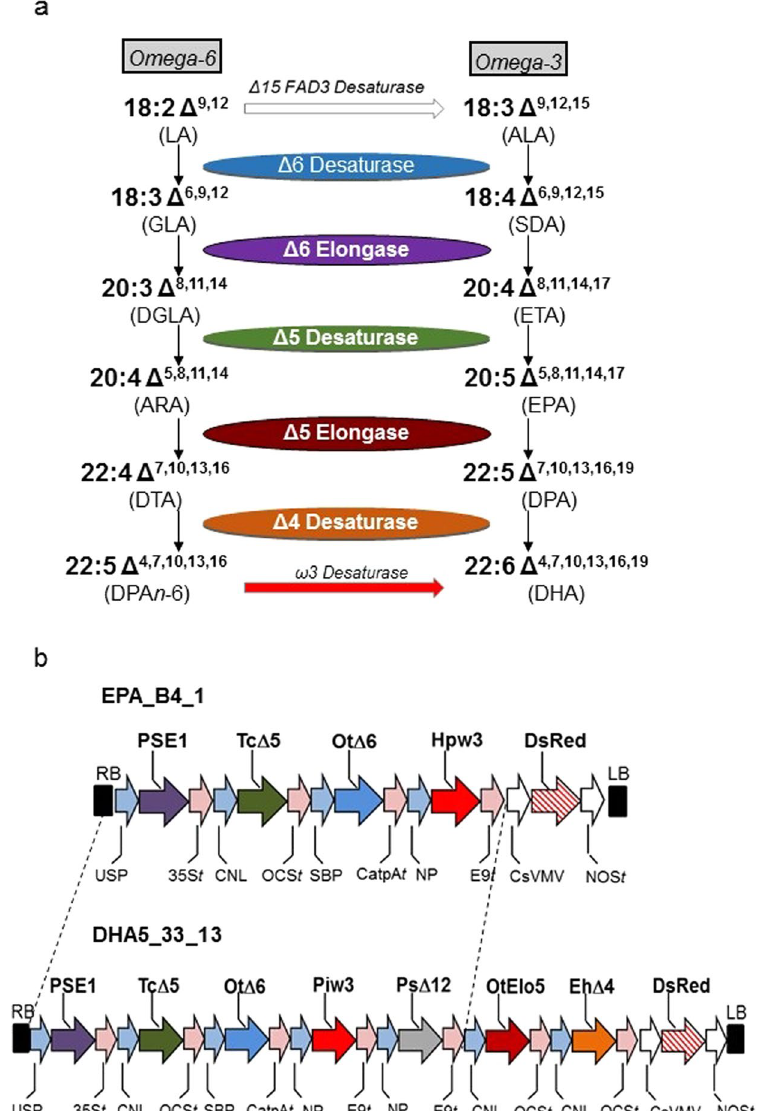
Figure 1. Production of EPA and DHA in the seeds of C. sativa . ( a ) The conventional Δ 6 biosynthetic pathway for the production of omega-3 LC-PUFAs EPA and DHA, with the various desaturase and elongase enzyme activities shown in different colours [also used in ( b )]. ( b ) Simplified maps of vectors EPA _B4_1 and DHA_33_13 used for transformation of C. sativa . Abbreviations: Cnl, conlinin 1 promoter for the gene encoding the flax 2S storage protein conlinin; USP, promoter region of the unknown seed protein of Vicia faba ; SBP, sucrose binding protein 1800 promoter; NP, napin; Ot ∆ 6, ∆ 6-desaturase from O. tauri ; Tc ∆ 5, a Δ 5-desaturase from Thraustochytrium sp.; Piw3, ω 3-desaturase from Phytophthora infestans ; Ps ∆ 12, a Δ 12- desaturase from Phytophthora sojae ; Eh Δ 4, ∆ 4-desaturase from E. huxleyi ; PSE1, a Δ 6-elongase from P. patens ; OtElo5, Δ 5-elongase from O. tauri ; OCS, 35S, E9 and CatpA represent